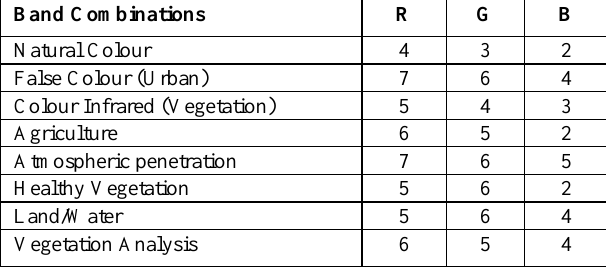
Table 2. Available bands combinations for various applications.